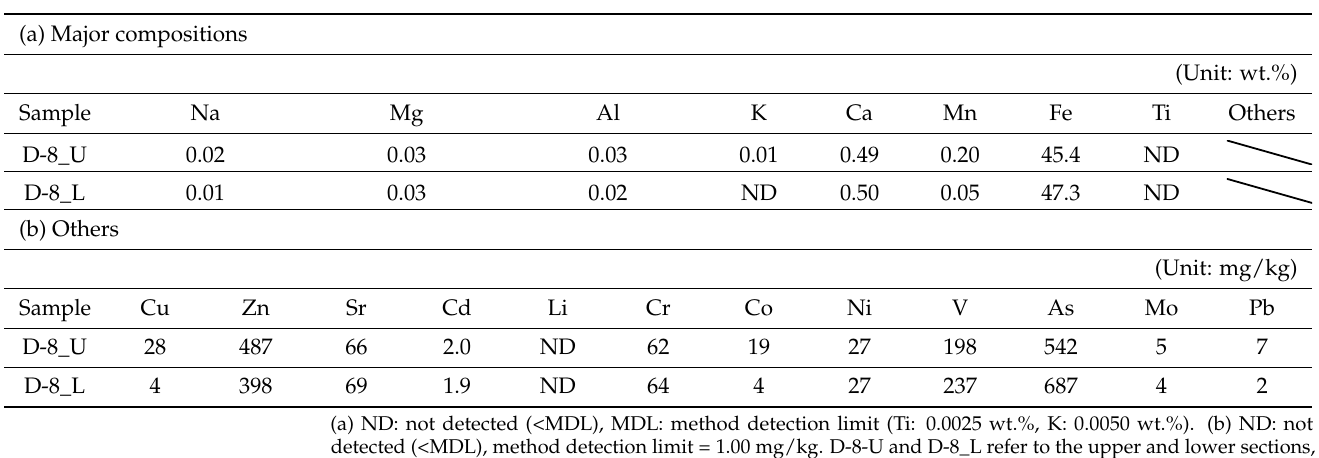
Table 6. Chemical analysis results of the materials deposited inside the pipe.